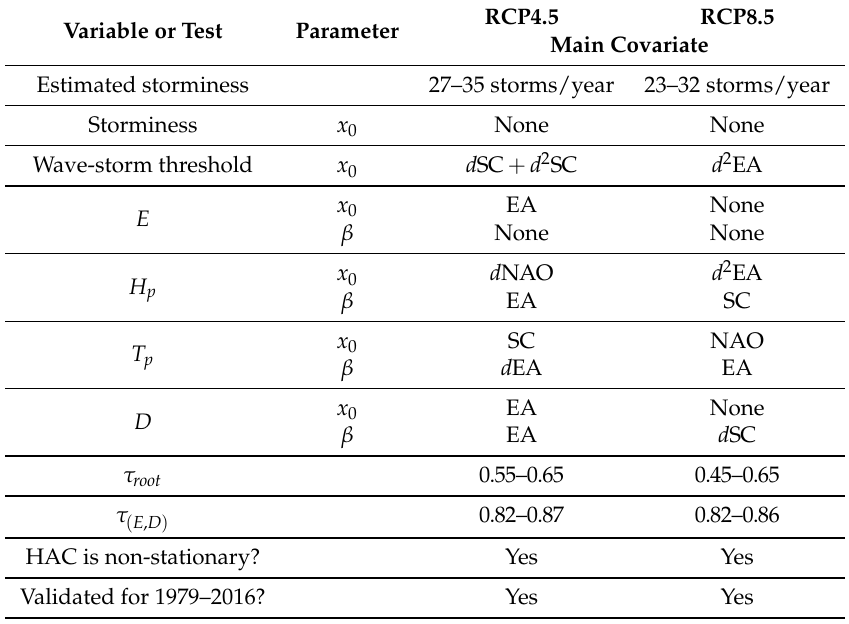
Table 2. Summary table of the Discussion section. d ( · ) and d 2 ( · ) are the first and second time-derivatives,